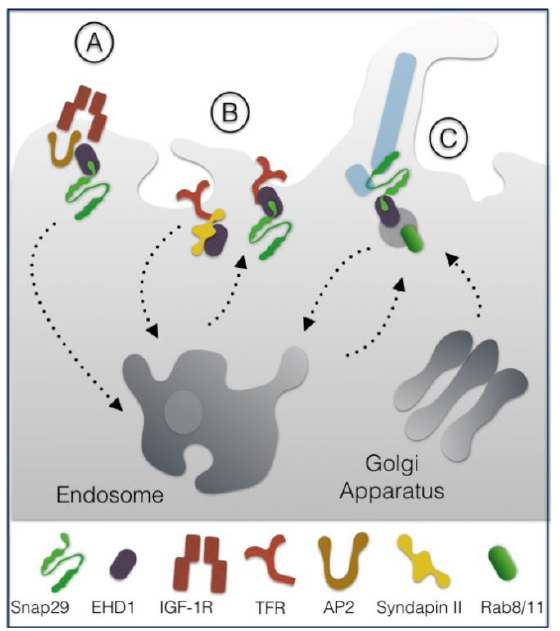
FIGURE 2 : Roles of Snap29 in endocytosis and recycling. Snap29 is required for internalization of the IGF-1R receptor (A) , for internalization and/or recycling of TFR (B) and for for- mation of the basal membrane surrounding the cilium microtu- bules (light blue; C ). All these functions are regulated in associa- tion with the endocytic factor EHD1, which binds the NPF motif of Snap29 (see text for details).